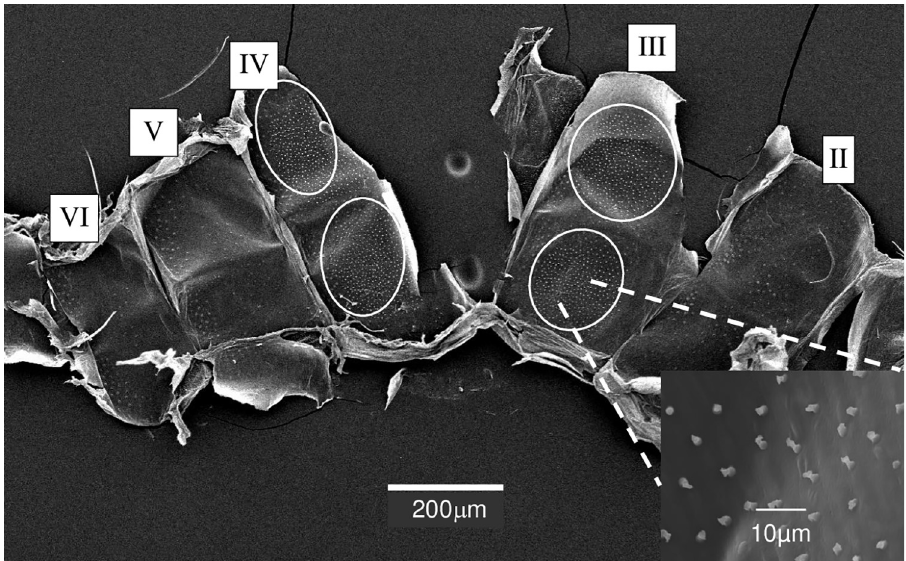
Fig 1. SEM of the interior cuticular surface of abdominal segments II-VI of Lu . longipalpis from Campo Grande showing the areas corresponding to pale patches normally seen from the exterior. Tergites II to VI are indicated by Roman numerals. The areas of the internal surface corresponding to the pale spots seen from the exterior area indicated by the white oval shapes. The insert is a close-up magnification of the cuticular structures associated with the secretory apparatus and seen within the oval-shaped (pale patch)